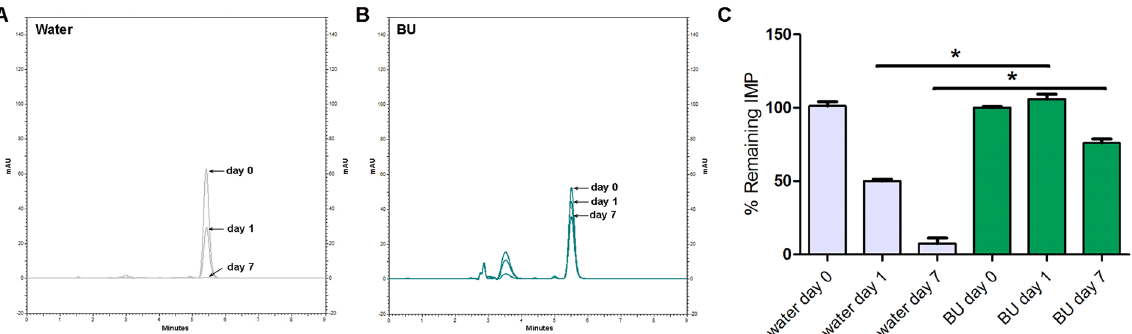
Figure 5. Representative chromatograms obtained of imipenem (IMP) dissolved in water ( A ) and in BU ( B ) of samples of 1 mg/ml after 0, 1 and 7 days. ( C ) Shows chromatogram quantification. Results are expressed as median ± SEM of three experimental